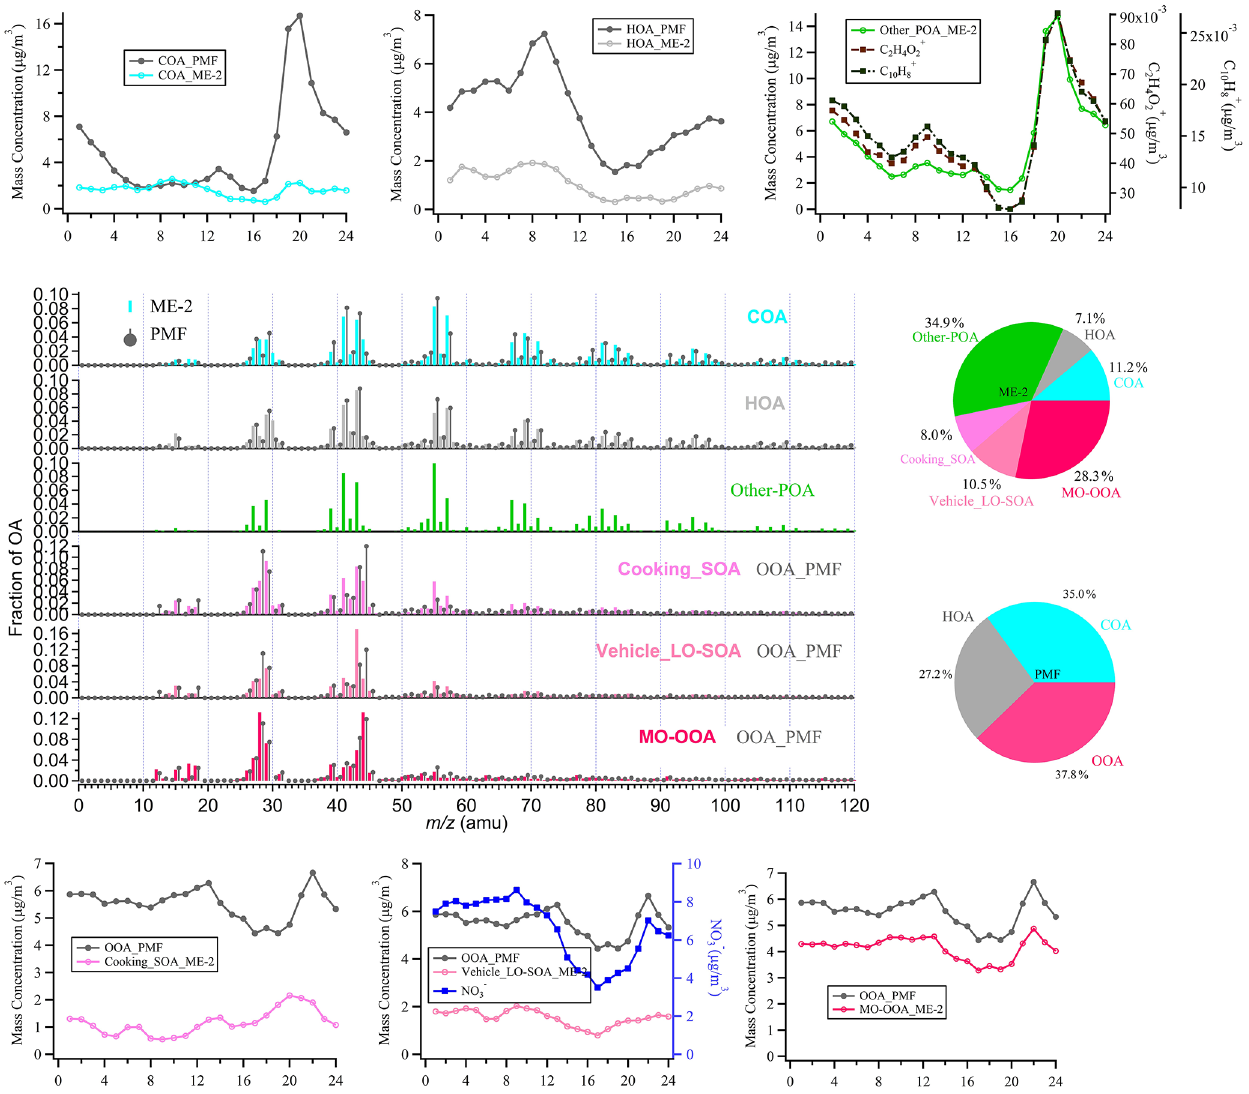
Figure 5. The comparison of the mass spectra, the diurnal variation, and fraction between ME-2 and PMF-resolved factors during the wintertime in Shanghai. The black lines in the spectra and diurnal pattern are the results of PMF analysis of the actual atmosphere in Shanghai winter. The others correspond to the ME-2 source analysis results by using two primary OA factors (the cooking POA and ambient HOA) and two secondary OA factors (the cooking SOA and the vehicle LO-SOA) as constraints, based on the same ambient OA data sets as the PMF model during the winter observations of Shanghai. Note that, in the mass spectra and daily patterns, the OOA_PMF factors which compared with vehicle LO-SOA and cooking SOA, respectively, are the same rather as the two resolved